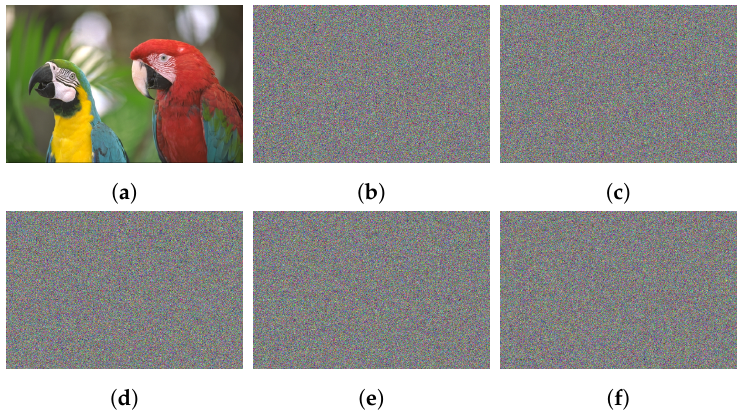
Figure 14. Outcomes of decrypting Cipher–Macaws image using slight changes in the